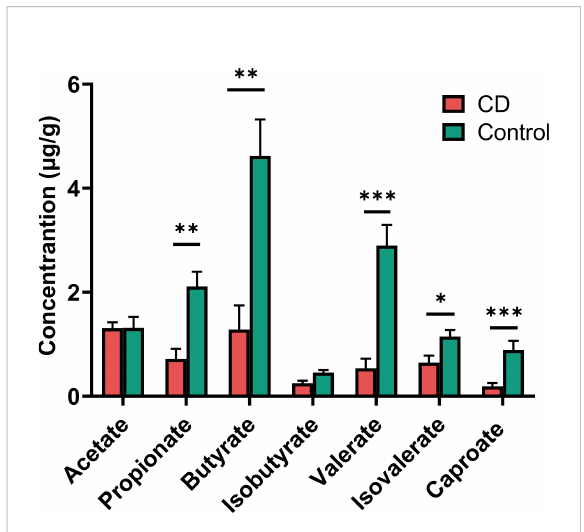
FIGURE 6 Short chain fatty acids (SCFAs) in the feces of CD patients and their healthy relatives. Propionate, butyrate, valerate, isovalerate and caproate were signi fi cantly decreased in CD patients compared to controls. P-values are from two-tailed Student t- tests. * P < 0.05; ** P < 0.01; *** P <